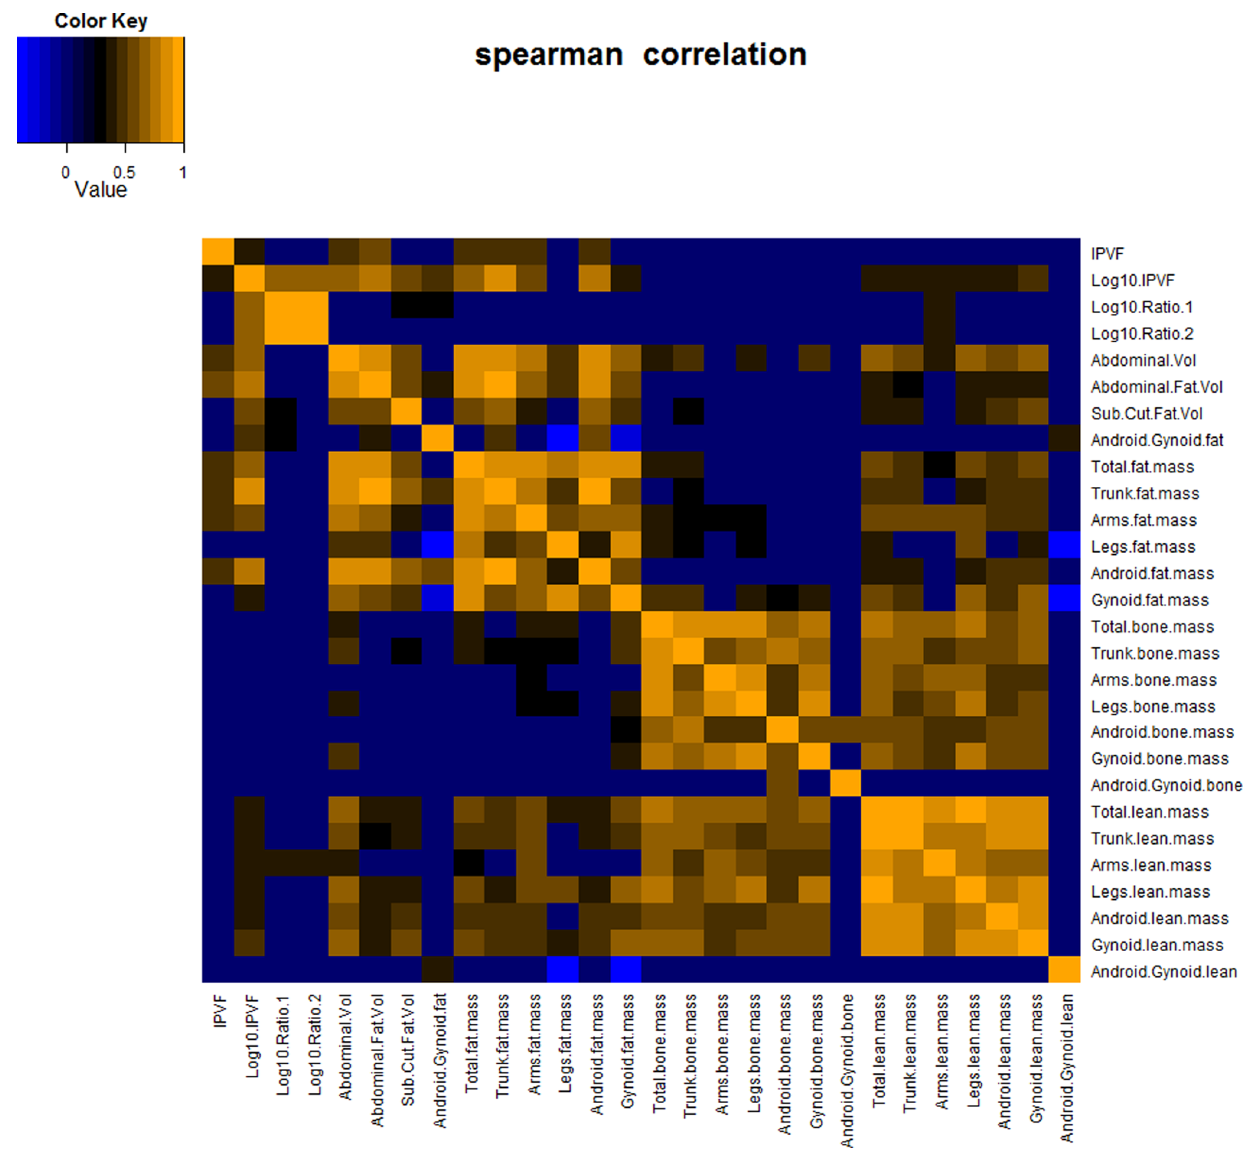
Figure 1. Statistically significant Spearman correlation map between CT scan and DXA body composition parameters (95% confidence interval). IPVF and Log 10 IPVF correlated similarly to fat body composition parameters. Log 10 IPVF showed a strong association with android/gynoid fat ratio (r=0.48, p=0.0015), Log 10 VAT/SAT (r=0.72, p , 0.001) and Log 10 VAT/total abdominal fat (r=0.71, p , 0.001), subcutaneous fat (r=0.58, p , 0.001), and some dependencies with lean mass parameters. Log 10 values of VAT/SAT and VAT/total abdominal fat ratios were poorly correlated with most body composition parameters, except for arms lean mass (r=0.43, p=0.0056; r=0.42, p=0.0070), whilst VAT/SAT correlated with subcutaneous fat (r=0.58, p=0.0489), and android/gynoid fat ratio (r=0.48, p=0.0453). NB: Blue denotes negative correlation, orange denotes positive correlation, and black denotes no correlation. doi:10.1371/journal.pone.0073445.g001 relationships between Log 10 ratio 1 and the other parameters were further assessed using a OPLS multivariate model (Figure S4).